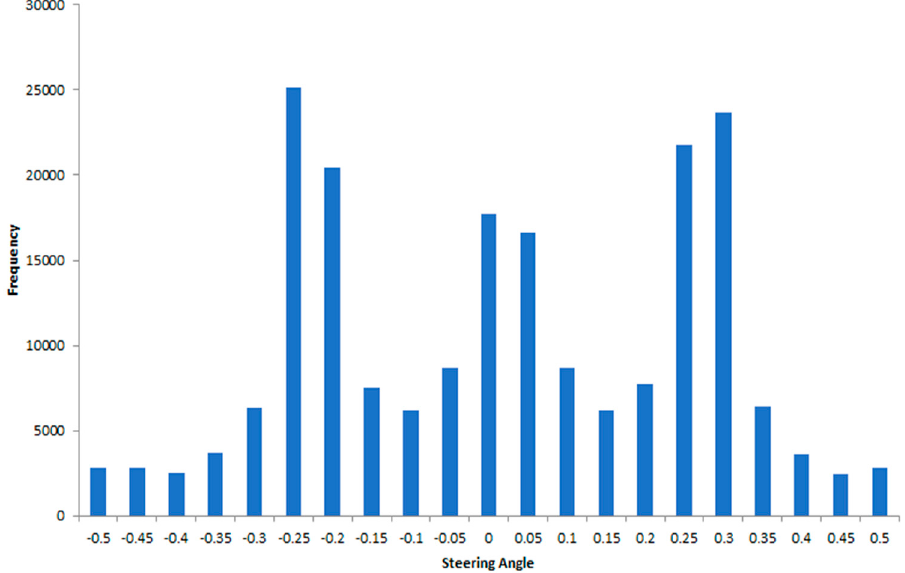
Figure 10. Histogram of the data after the normalization and augmentation process.